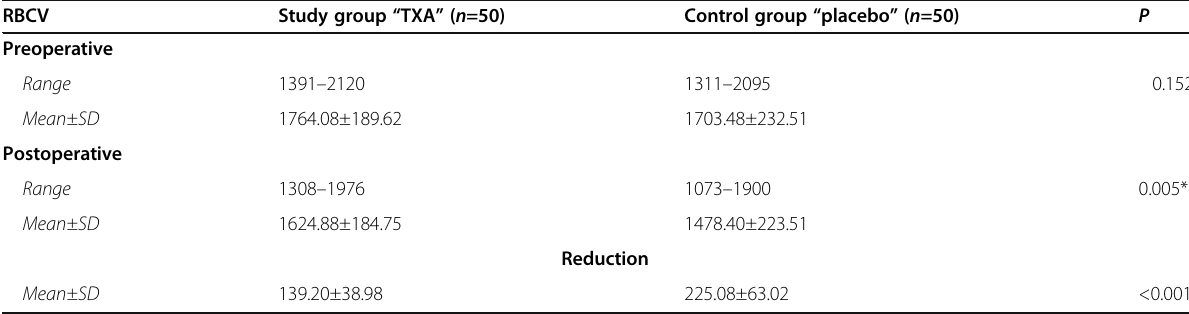
Table 3 Red blood cell volume (RBCV) RBCV Study group “ TXA ” ( n =50)